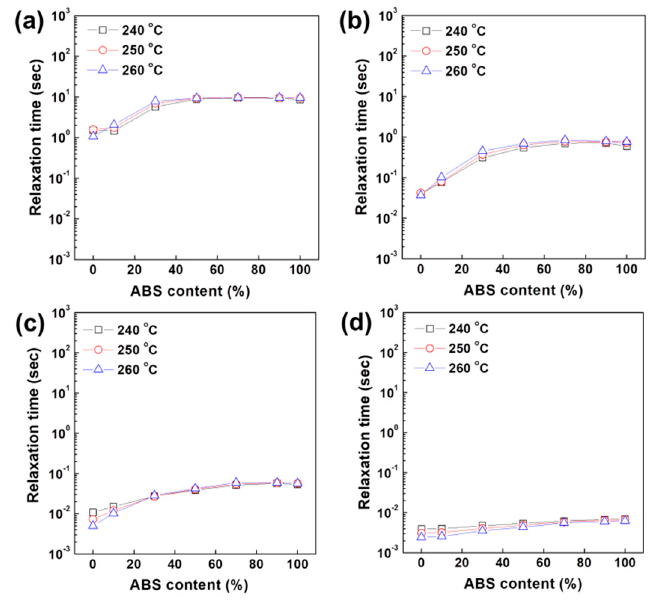
Figure 7. Change of relaxation time of PC / ABS blends at given frequency of ( a ) 0.1, ( b ) 1, ( c ) 10 and ( d )